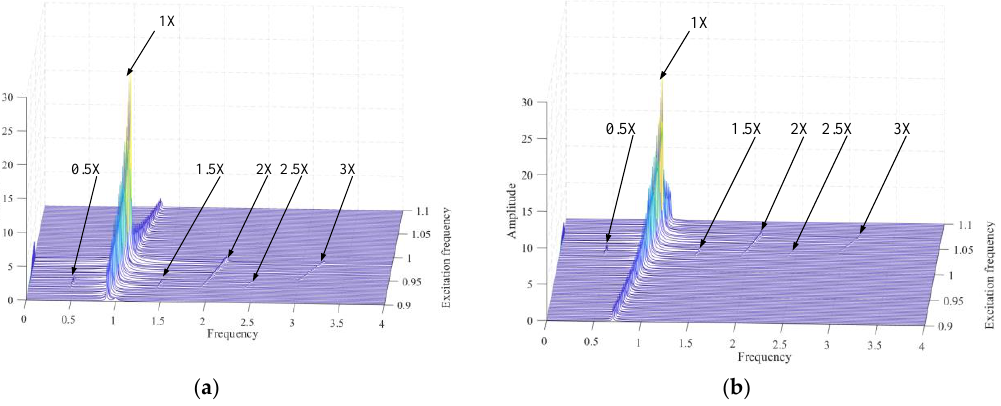
Figure 15. 3D waterfall diagram of the process of continuous increase or decrease of excitation frequency: ( a ) frequency increase (speed-up); ( b ) frequency decrease (coast down).